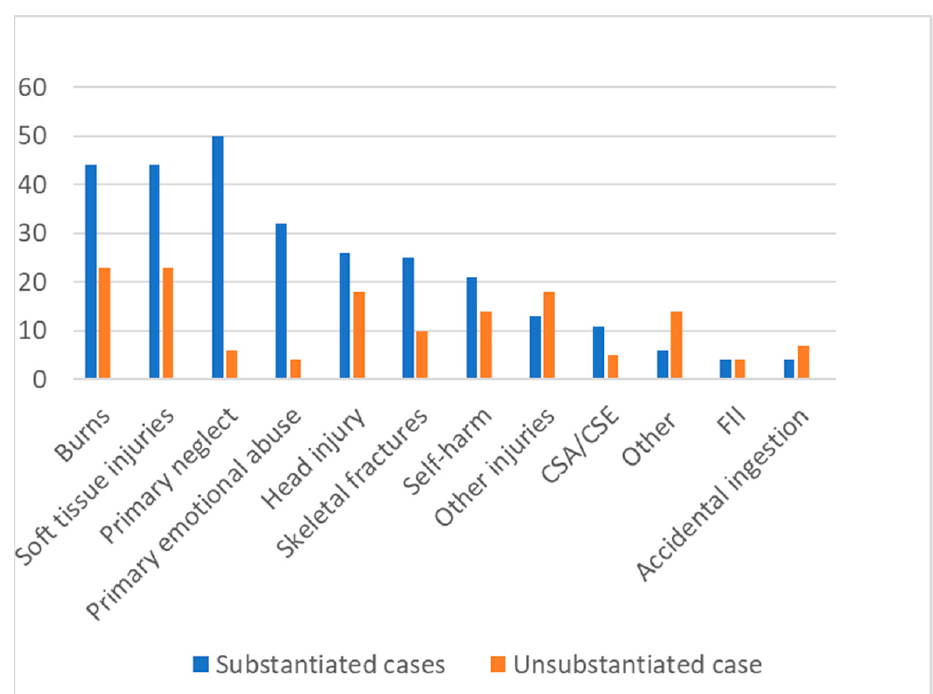
Figure 4. Referral characteristics of the sample.